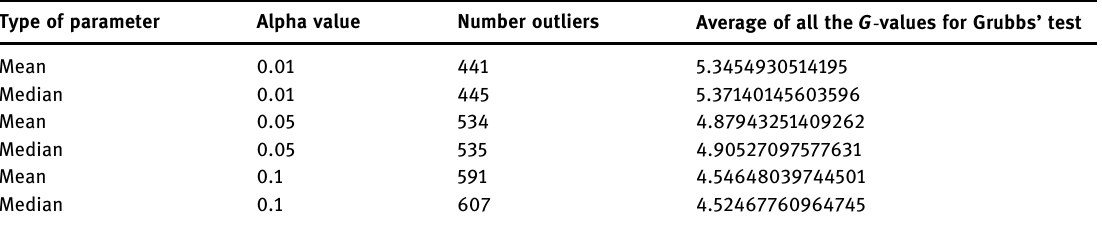
Table 1: Two types of parameters and the α values of Grubbs ’ test for 1,000 replications